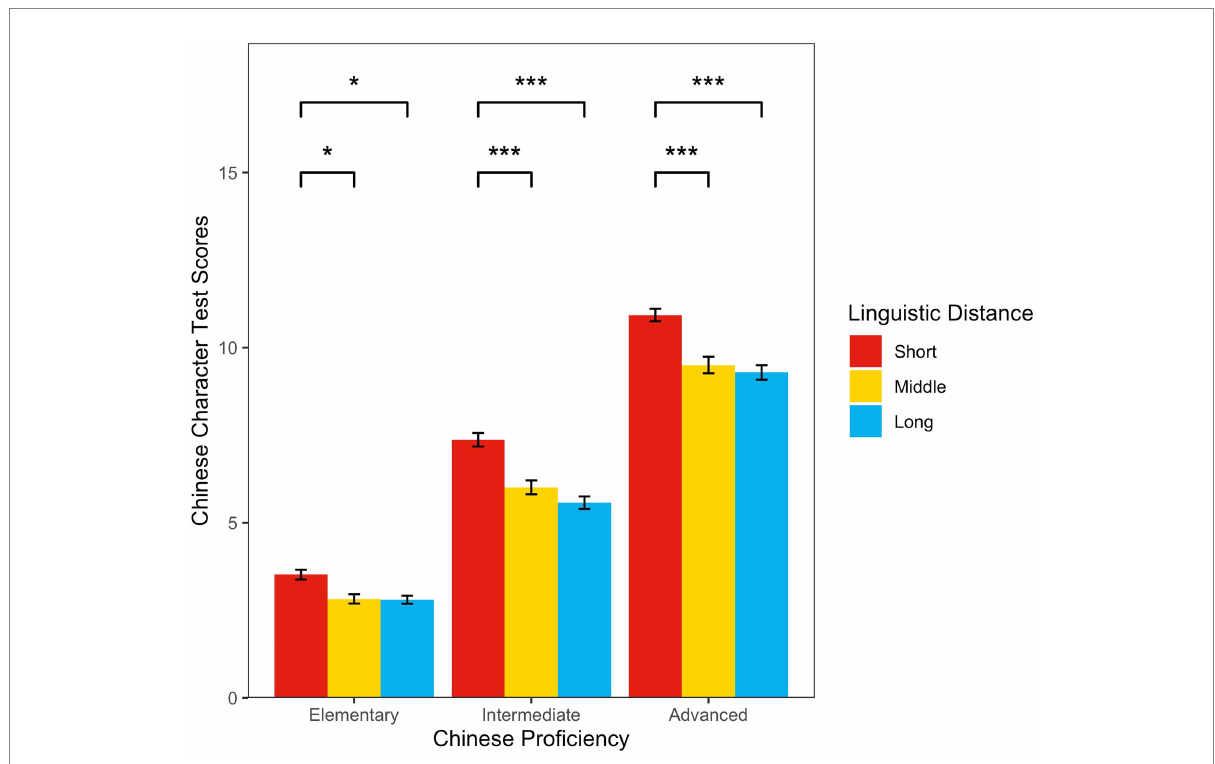
FIGURE 2 The relationship between Chinese proficiency, linguistic distance, and Chinese character test